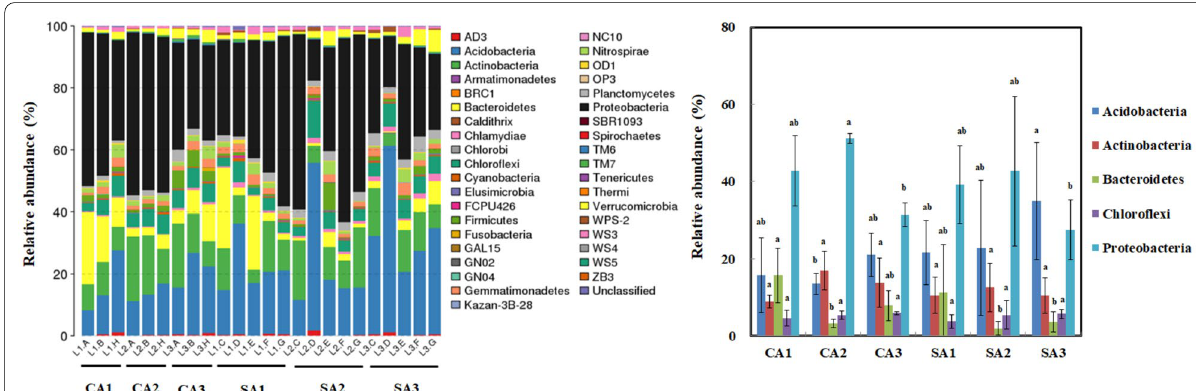
Fig. 3 Temporal variation in the Phylum‑level distribution of OTUs in the soil samples of litchi orchards that were maintained under conventional (CA) and sustainable (SA) agricultural practices. 1, 2 and 3 indicate successive trimester samplings carried out on October 2016, January 2017 and April 2017, respectively. Graph showing the taxonomic composition distribution was generated by the R software. The dominant phyla including Acidobacteria, Actinobacteria, Bacteroidetes, Chloroflexi, and Proteobacteria were further compared. Results are shown as mean